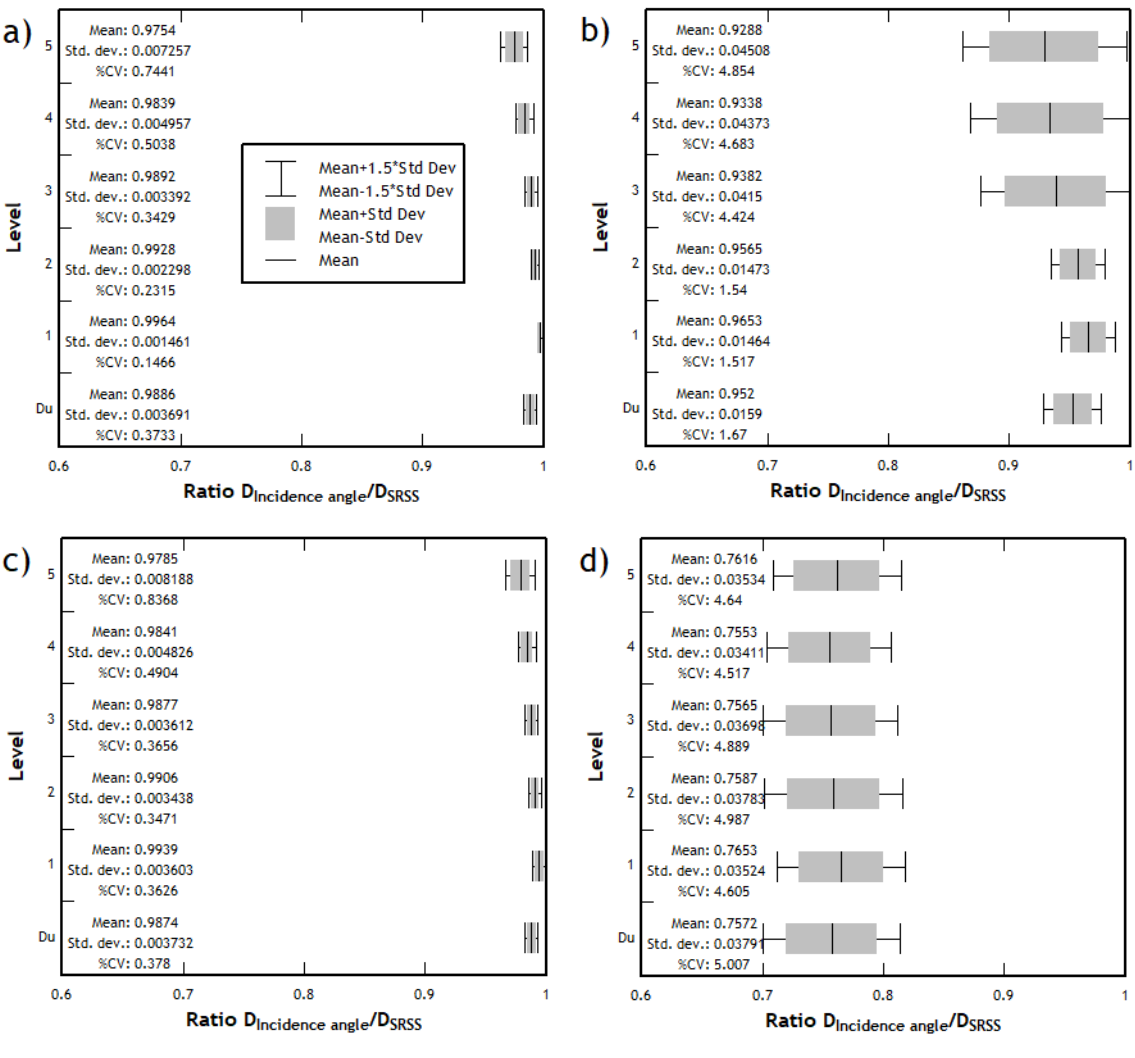
Figure 16. Ratio of the interstory drifts achieved with different angles of incidence with respect to the displacements achieved using SRSS combination for ( a ) Archetype 1, ( b ) Archetype 2, ( c ) Archetype 3, and ( d ) Archetype 4.